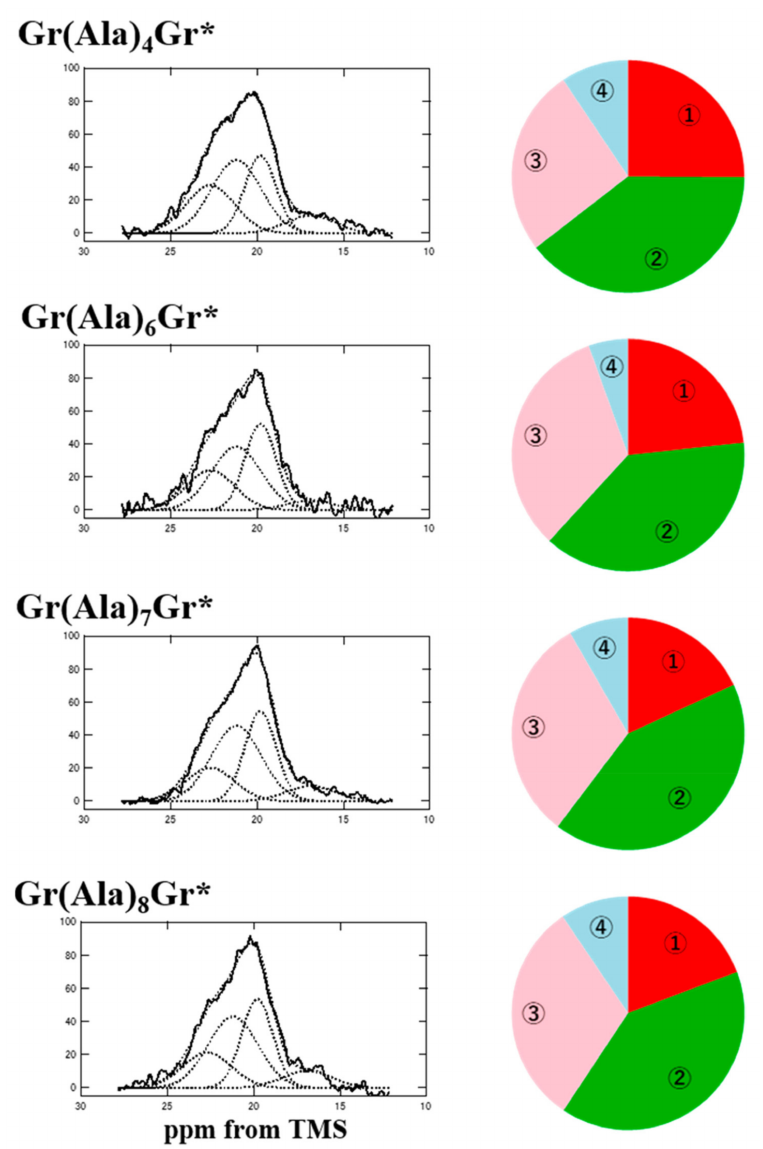
Figure 8. ( Left ) Expanded dipolar dephasing 13 C DD / MAS NMR spectra of the Ala C β regions of Gr(Ala) n Gr* ( n = 4 and 6 − 8) after FA / MeOH treatment [63]. The decomposed four spectra shown by broken lines were obtained by the deconvolutions under assuming the chemical shifts as 22.7, 21.2, 19.8 and 16.9 ppm from lower field to higher field, respectively. ( Right ) Pie charts of the fractions determined by the deconvolutions. The color of the fraction is 1 (cid:79) red (22.7 ppm), 2 (cid:79) green (21.2 ppm), 3 (cid:79) pink (19.8 ppm), and 4 (cid:79) light blue (16.9 ppm;